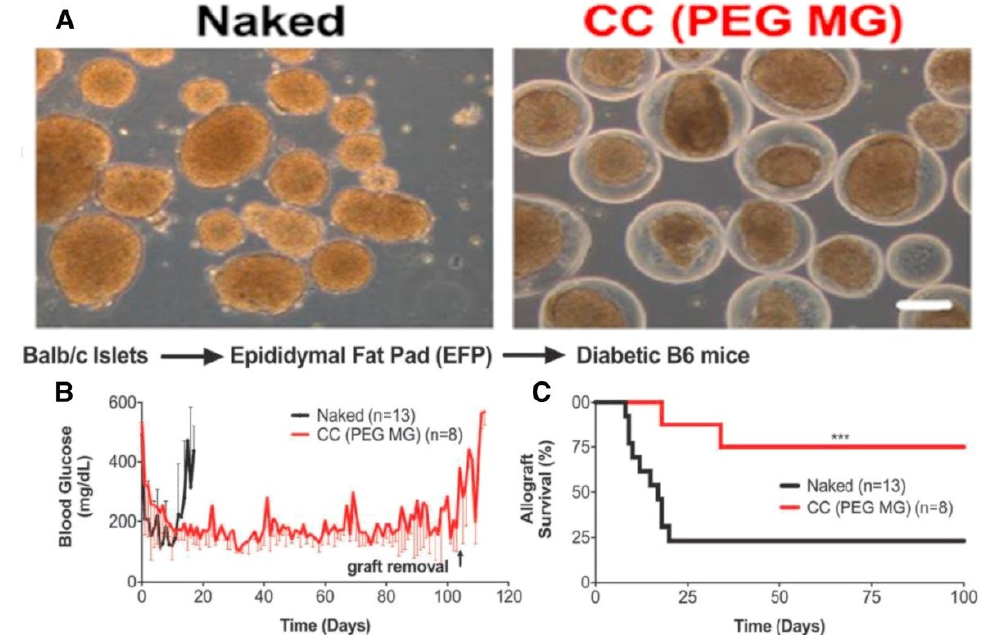
Figure 5. PEG-MAL Matrigel-conformed coated islets transplanted in the epididymal fat pad (EFP) site reverse diabetes in the long term in murine allografts without immunosuppression [129]. Copyright 2018. ( a ) Phase contrast (scale bar, 100 μ m) and scanning electron microscopy (SEM); ( b , c ) Blood glucose of recipient mice ( b ) and survival ( c ) of 750–1000 IEQ naked (black, n = 13) or CC (PEG MG) (red, n = 8) islets from Balb/c mice transplanted into fully MHC-mismatched chemically induced diabetic B6 mice in the EFP site using fibrin scaffolds without any immunosuppression.